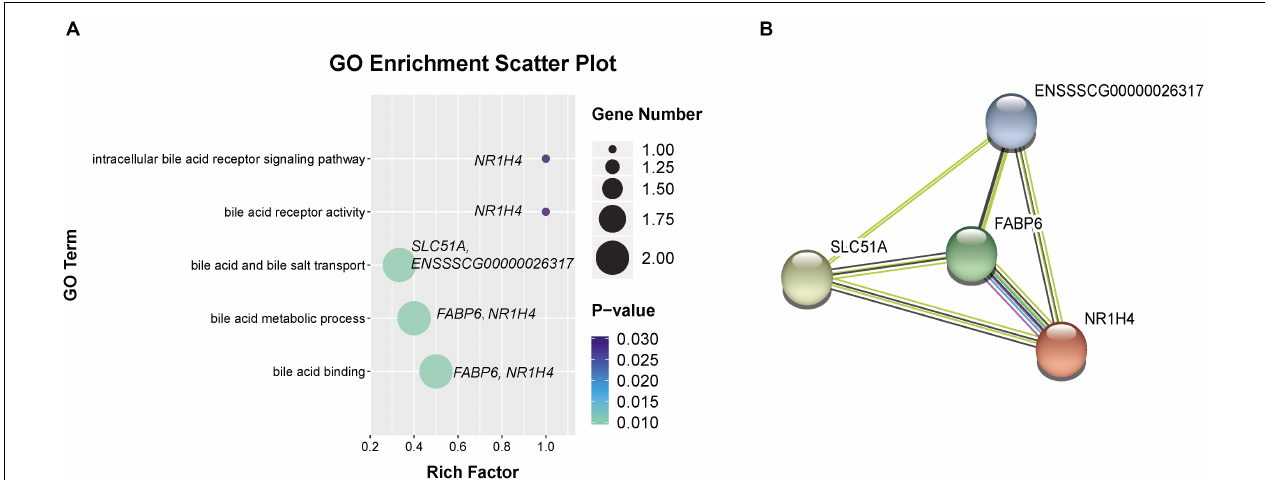
FIGURE 6 | Go terms related to bile acid metabolism. (A) GO terms related to bile acid metabolism were increased by weaning. (B) Interaction networks of proteins encoded by DEGs related to bile acid metabolism. Line colors represent different evidentiary sources for each interaction: light blue, from curated databases; purple, experimental; green, gene neighborhood; red, fusion; blue, gene cooccurrence; yellow, text mining; black, coexpression; light purple, protein homology. Disconnected nodes are not shown in the